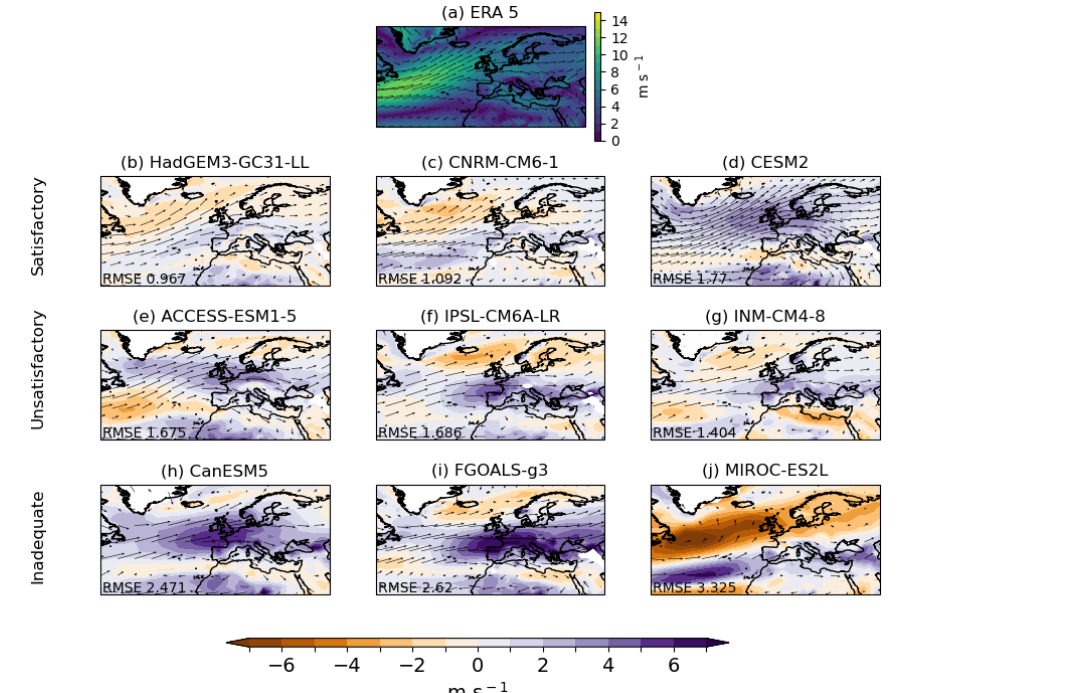
Figure 2. Examples of DJF circulation (850hPa) classifications for a sample of individual models. Top panel shows ERA5 climatology. Wind speed and direction are shown as a 20-year mean (1995–2014). Arrows show the direction (absolute) of wind speed (scaled by wind speed) for climatology across all panels. The shading for the three panels shows the difference in wind speed between the model and ERA